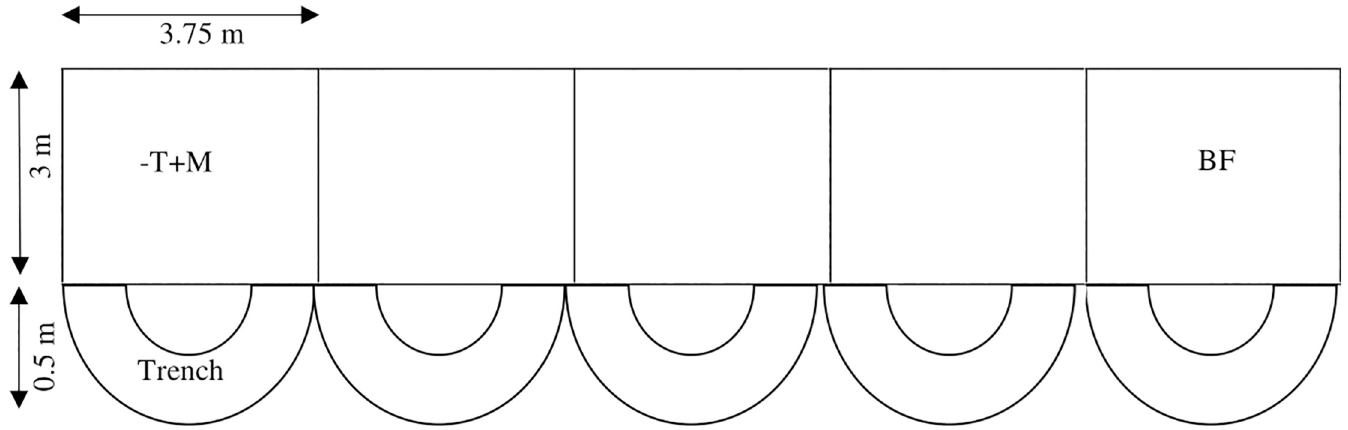
Fig 2. Soil erosion experimental plots (T = Tillage, M = Mulch and BF = Bare Fallow).